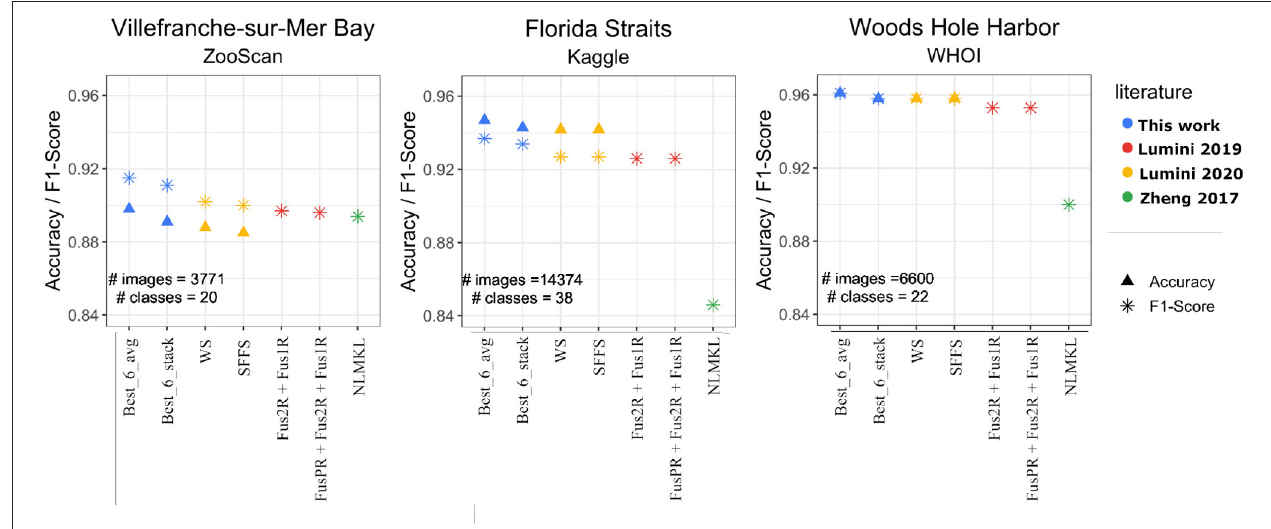
Frontiers in Microbiology |